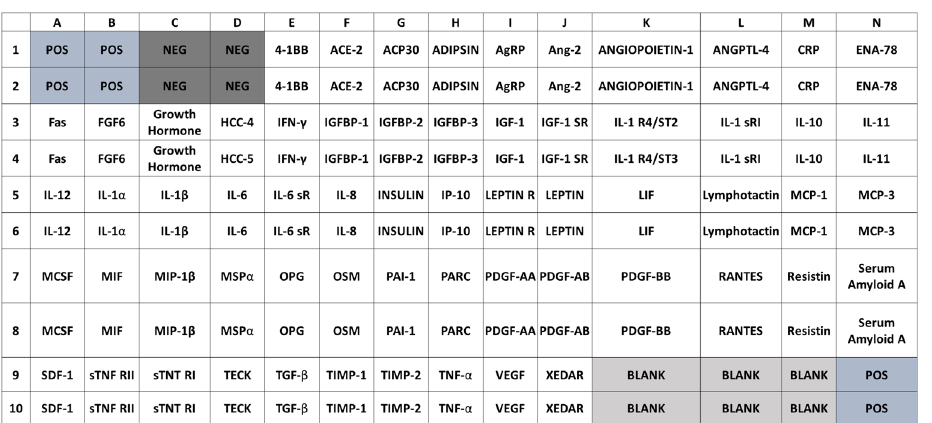
Figure 1. Spot map of anti-adipokine antibodies. Captured antibodies are spotted on a membrane with each pair of spots representing a different adipokine. Positive (POS), negative (NEG), and BLANK control spots are highlighted. POS spots: printed with biotin-conjugated Immunoglobulin (Ig) G protein; NEG spots: printed with the same buffer used to dilute antibodies printed on the array; BLANK spots: no printing.